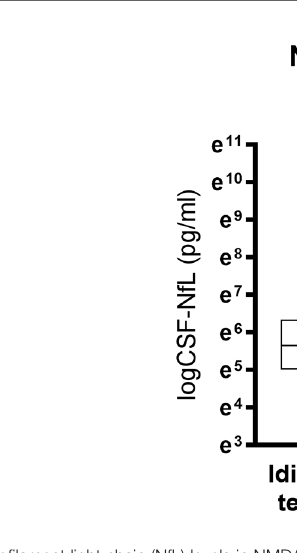
FIGURE 3 | CSF-Neuro fi lament light chain (NfL) levels in NMDAR-AE subgroups. Patients with idiopathic/teratoma associated NMDAR-AE had signi fi cantly lower CSF-NfL levels at diagnosis than patients with secondary NMDAR-AE due to post-Herpes Simplex Virus 1 Encephalitis (Post-HSE) or underlying demyelinating conditions or malignancies (secondary). NMDAR-AE patients with teratomas are shown as green datapoints, demyelinating as red and malignancies as blue datapoints. ****p value <